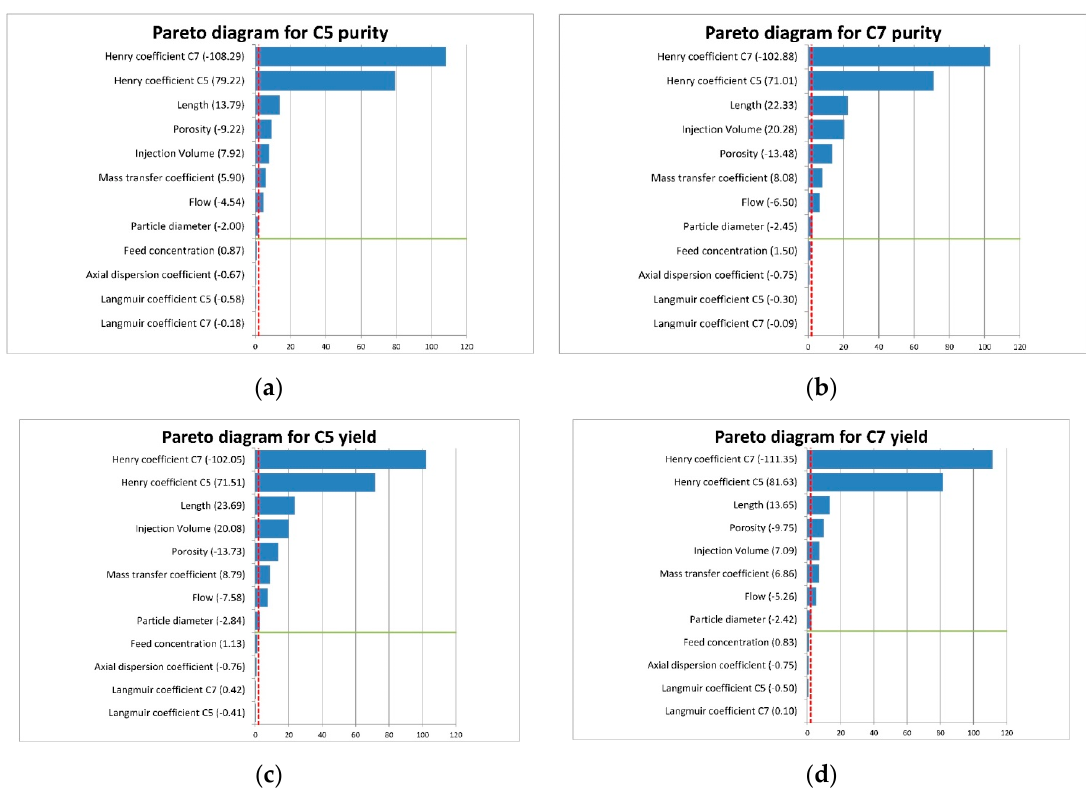
Figure 8. Pareto charts of standardized effects for ( a ) cyclopentanone purity, ( b ) cycloheptanone purity, ( c ) cyclopentanone yield, and ( d ) cycloheptanone yield.